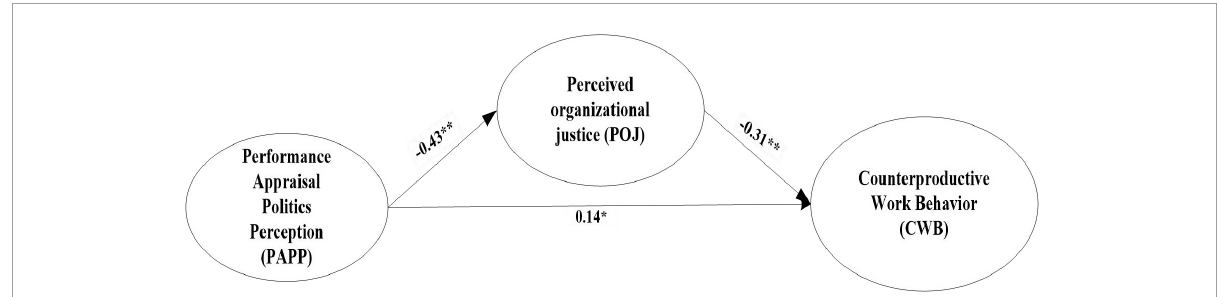
FIGURE3 The mediating model of perceived organizational justice. N = 460, ** p < 0.01, * p < 0.05.